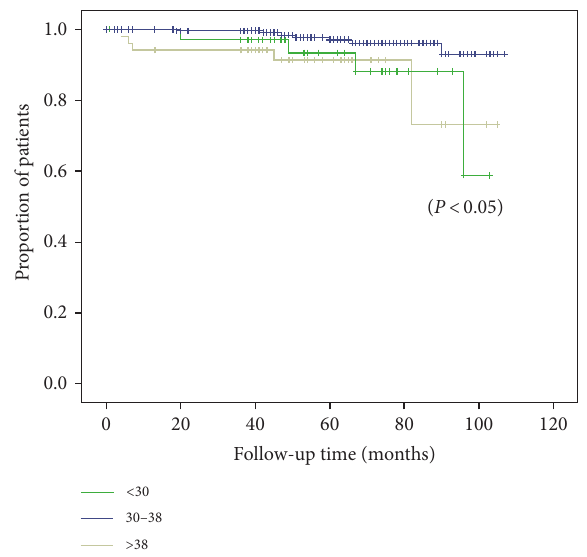
Figure 1: Recurrence of PTC according to length of reproductive